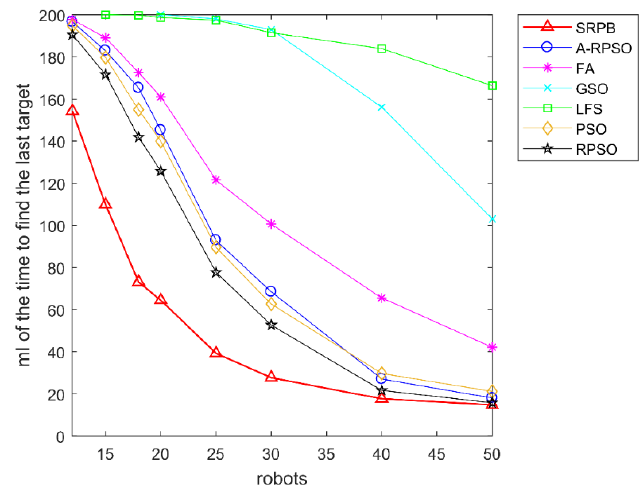
Figure 12. Average time to find the last source in the different population sizes and the different initial positions of robots.